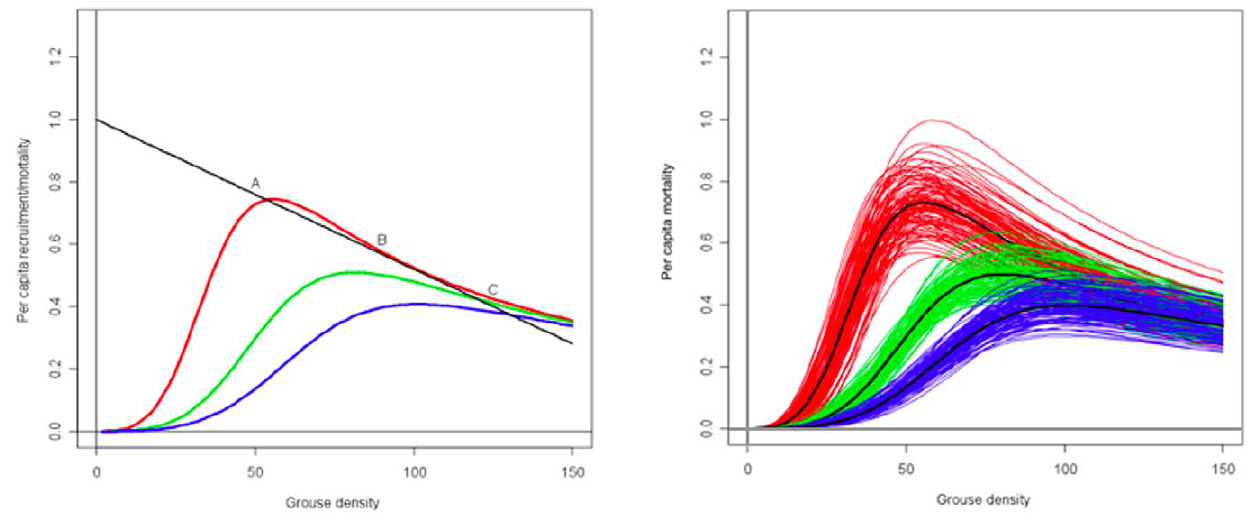
Figure 2. Relationship between the density of grouse chicks, per capita grouse recruitment and per capita chick mortality induced by a population of hen harriers. (a)Harriers were assumed to be present at a density of 0.16 pairs.km 2 2 (which is typical for the study sites [32]). The equilibrium density for the grouse population in the absence of harriers is assumed to be 208 chicks.km 2 2 [35]. Mortality curves are shown for the same three densities of alternative prey as those in Fig. 1 (red=low, green=intermediate, blue=high). Equilibria occur where the mortality curves and the recruitment line intersect. Equilibria A and C are stable, equilibrium B is unstable. (b)Uncertainty in the relationship between harrier- induced chick mortality and chick density. Each curve shows the mortality for one set of parameter values drawn at random from the joint posterior distribution for the MSFR model, thus taking account of any correlation among the parameters.